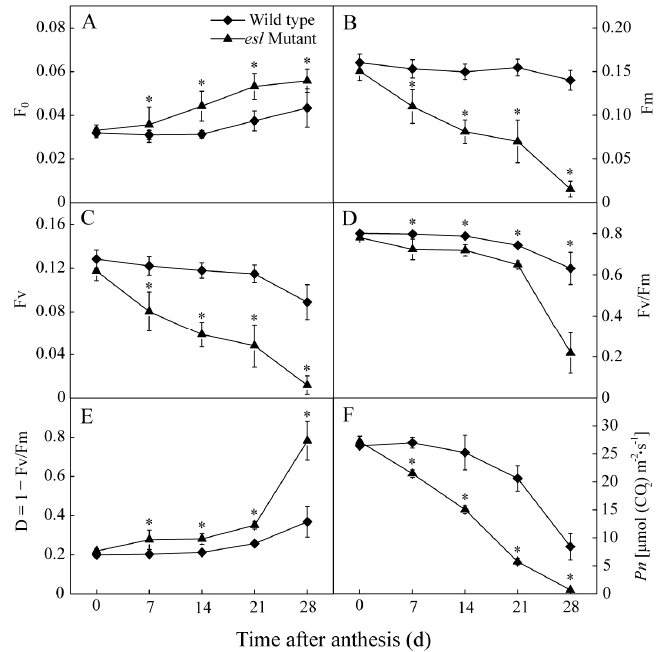
Figure 5. Genotype-dependent differences in the temporal changes in ( A ) minimal fluorescence yield (F 0 ), ( B ) maximal fluorescence yield (Fm), ( C ) variable fluorescence (Fv), ( D ) Fv/Fm, ( E ) 1 − Fv/Fm, and ( F ) net photosynthetic rate ( Pn ) for the flag leaves of the two rice genotypes during the grain-filling stage. Vertical bars represent standard errors ( n = 3). The asterisks represent significant differences between the esl mutant and its wild-type cultivar (* p < 0.05).